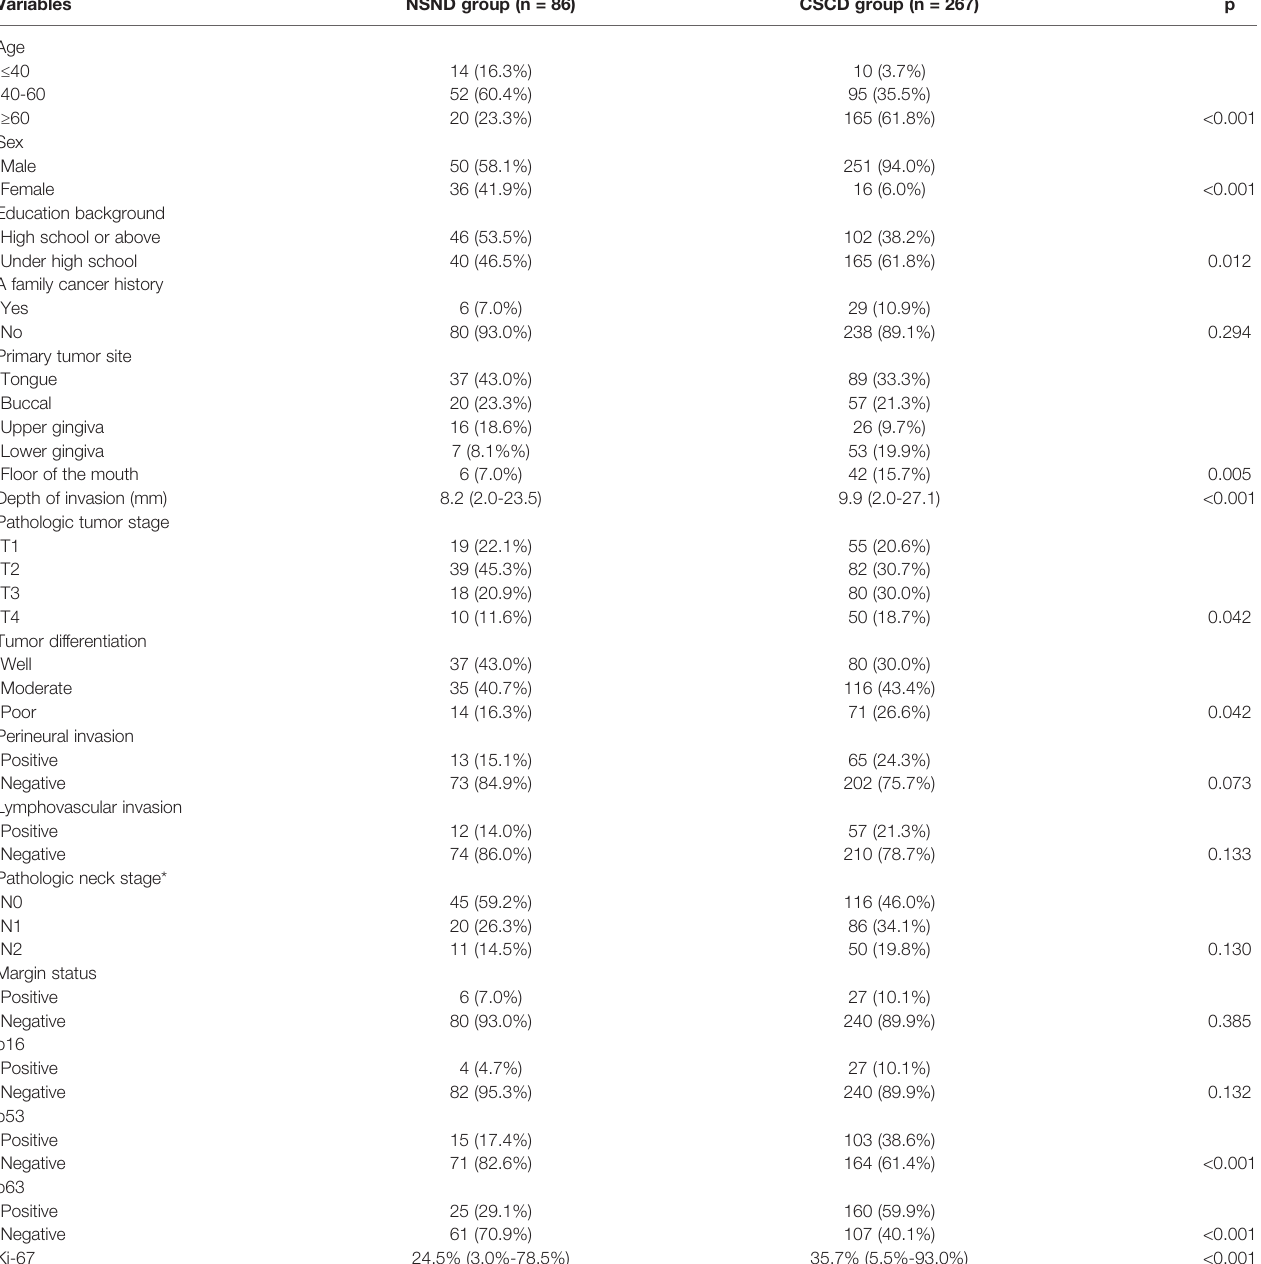
TABLE 1 | Comparison of demographic, pathologic, and molecular information between the non-smoker and non-drinker group (NSND) and the current-smoker/ current-drinker (CSCD) group.